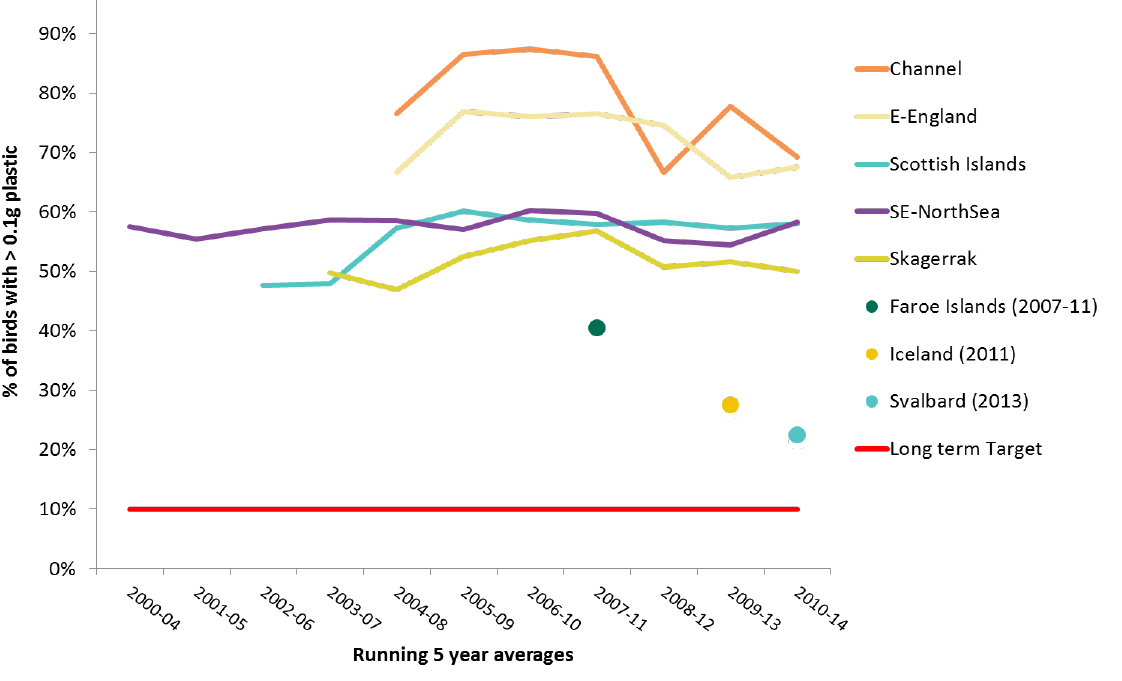
Figure 2: Running five-year averages for the percentage of fulmars having more than 0.1 g of plastic in their stomach since 2000 and/or the start of sub-regional participation in the monitoring programme. Incidental data published for the Faroe Islands, Iceland and Svalbard are included to illustrate lower levels further north in the OSPAR Maritime Area, but nevertheless still well above the OSPAR long-term goal